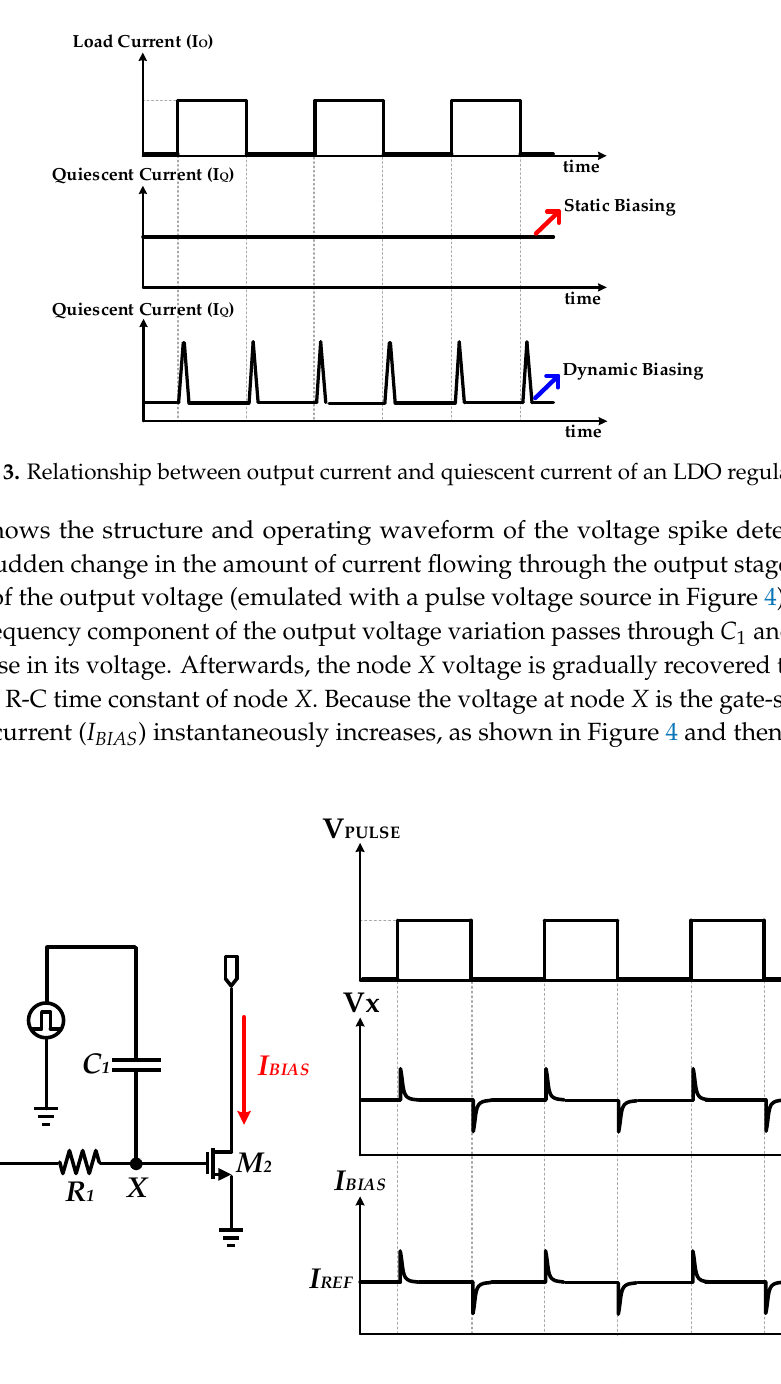
Figure 4. Operation principle of voltage spike detection circuit.